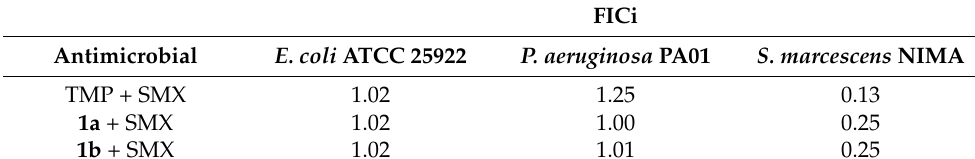
Table 4. FICi of TMP and compounds 1a and 1b with SMX (1:20) when tested with colistin.